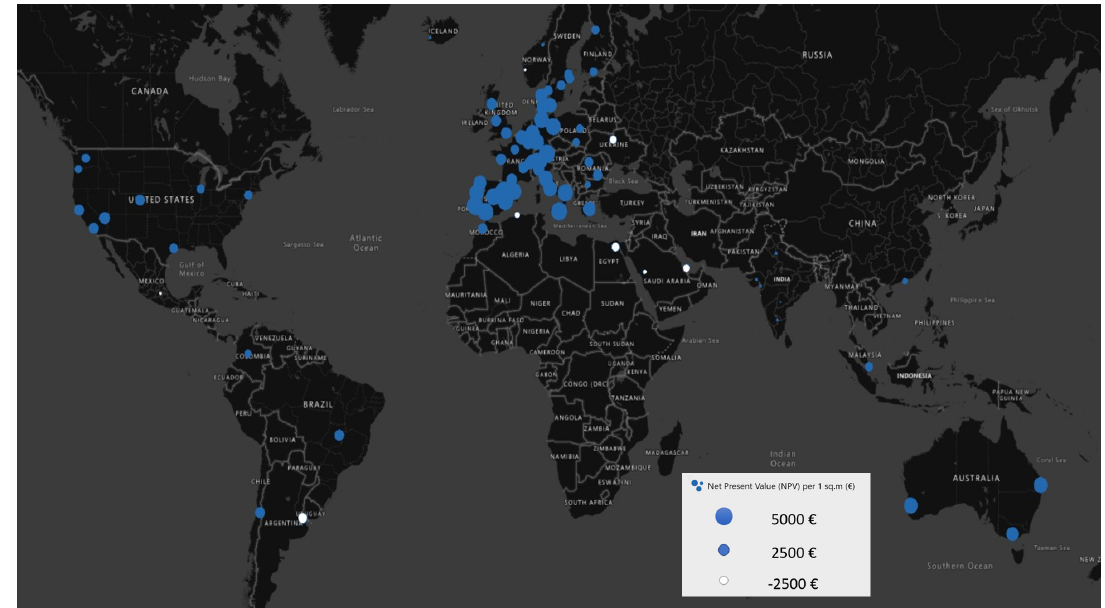
Figure 23. NPV potential per unit collector area for financing model 2.